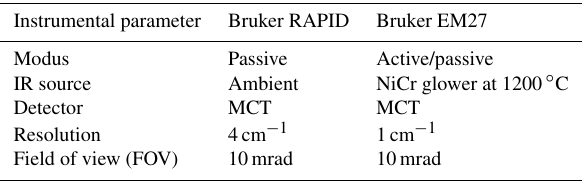
Table 1. OP-FTIR spectrometer device parameters.